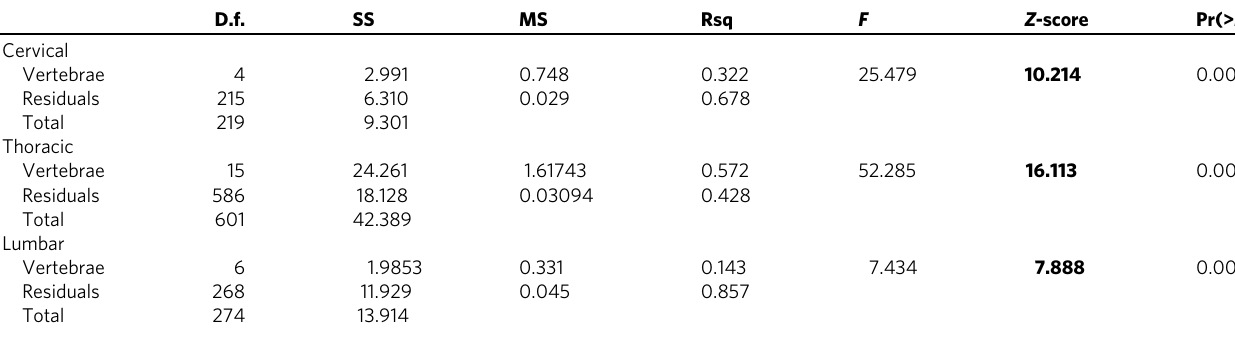
Table 1 Results of the three Procrustes ANOVAs for the three regions and grouping by vertebrae.